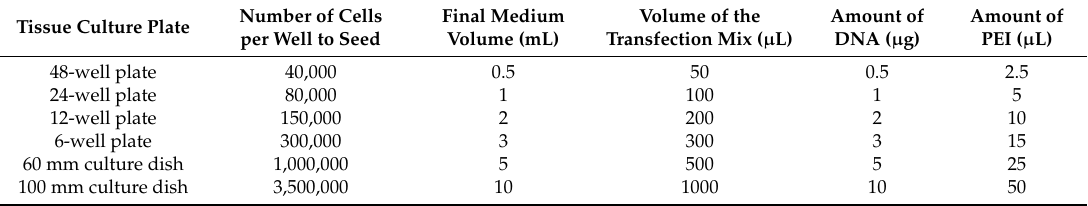
Table 1. Approximate numbers of cells and reagents for HEK293T